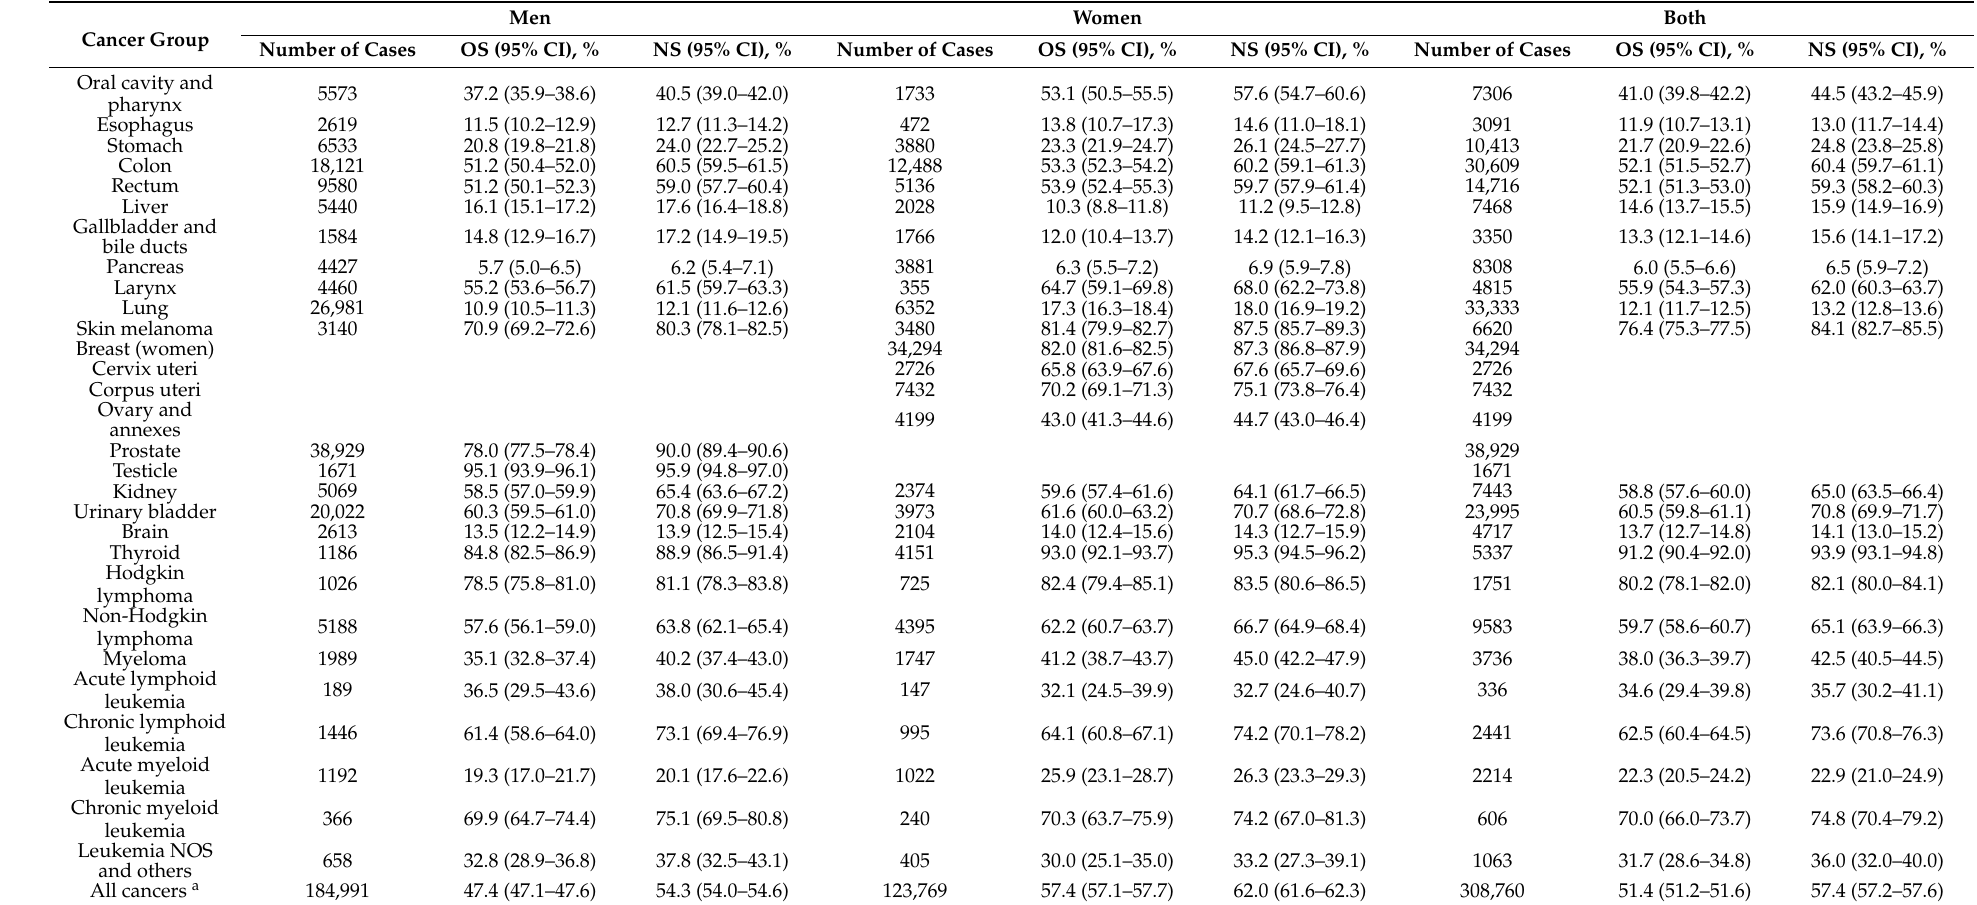
Table 2. Five-year observed survival (OS) and net survival (NS) by sex in adult patients diagnosed with cancer in Spain in